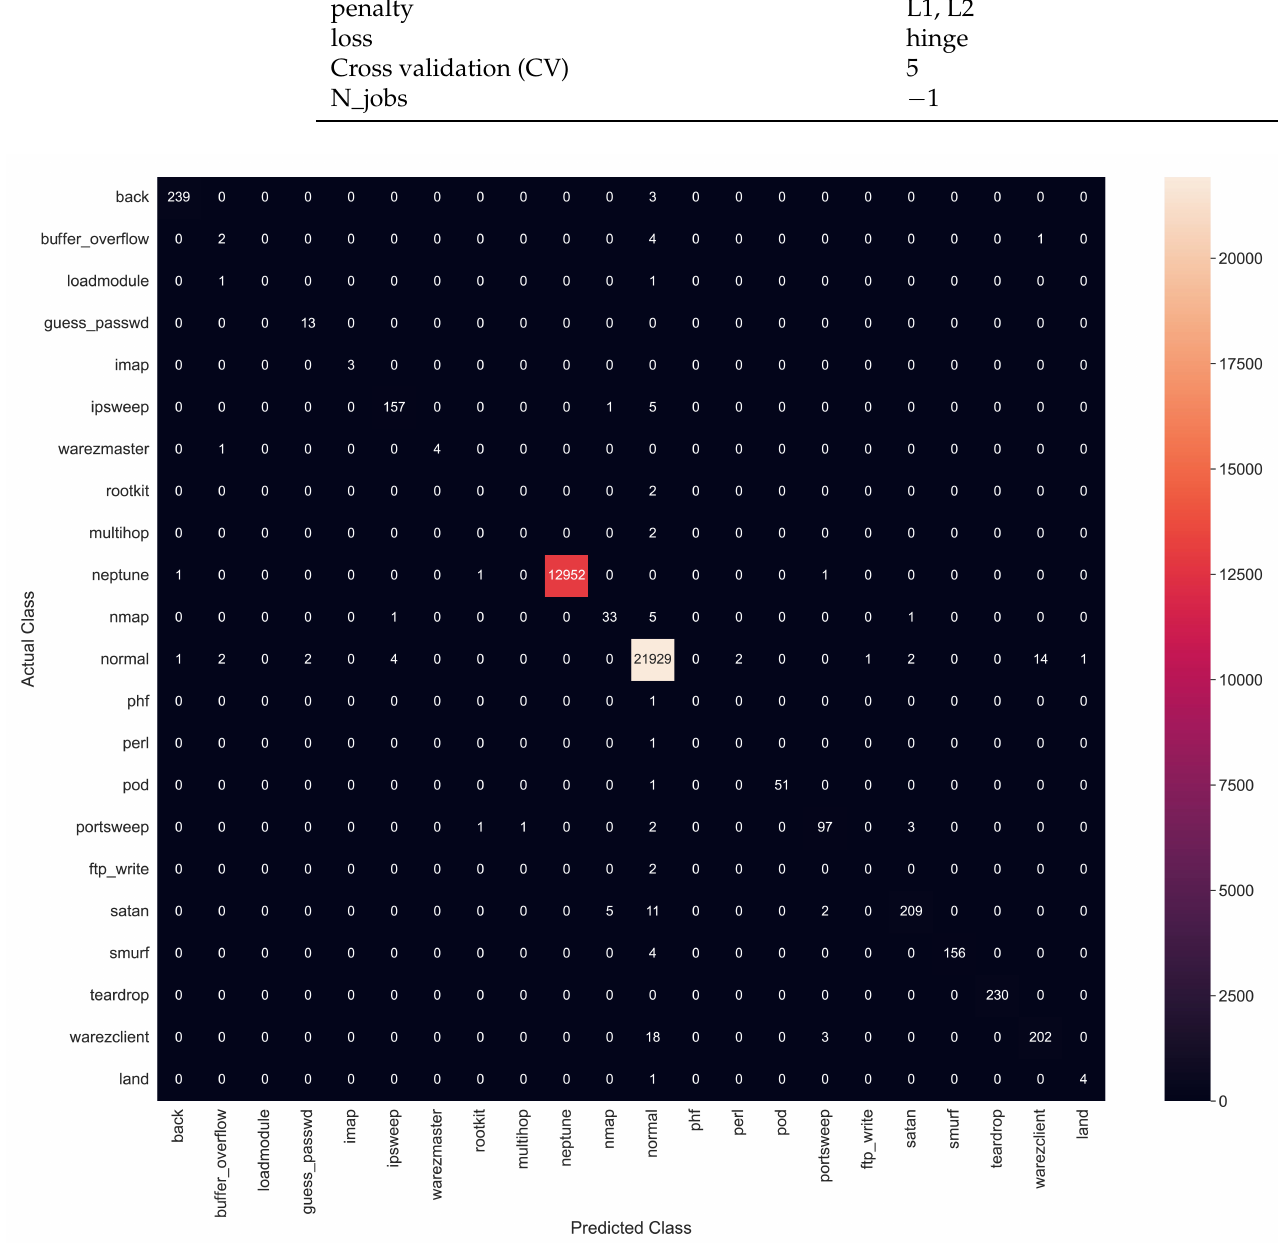
Figure 12. Confusion matrix for Support Vector